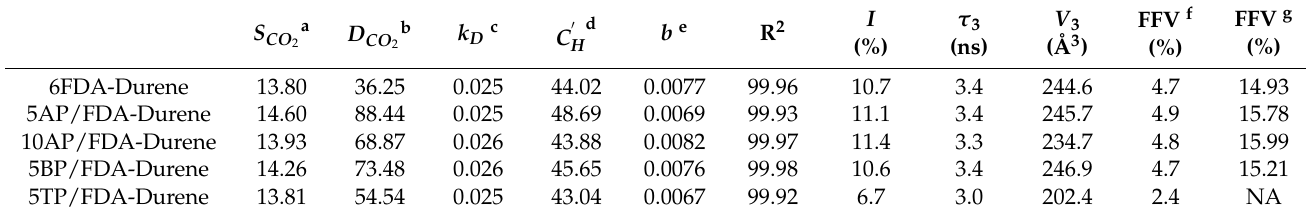
Figure 6. CO 2 ( solid square ) and CH 4 ( hollow square ) uptake at 30 °C of: ( a ) MMMs with AP loading; ( b ) MMMs with BP loading; ( c ) MMMs with TP loading; and ( d ) microporous PIs. Table 5. CO 2 dual-mode sorption fitting parameters at 30 ◦ C and